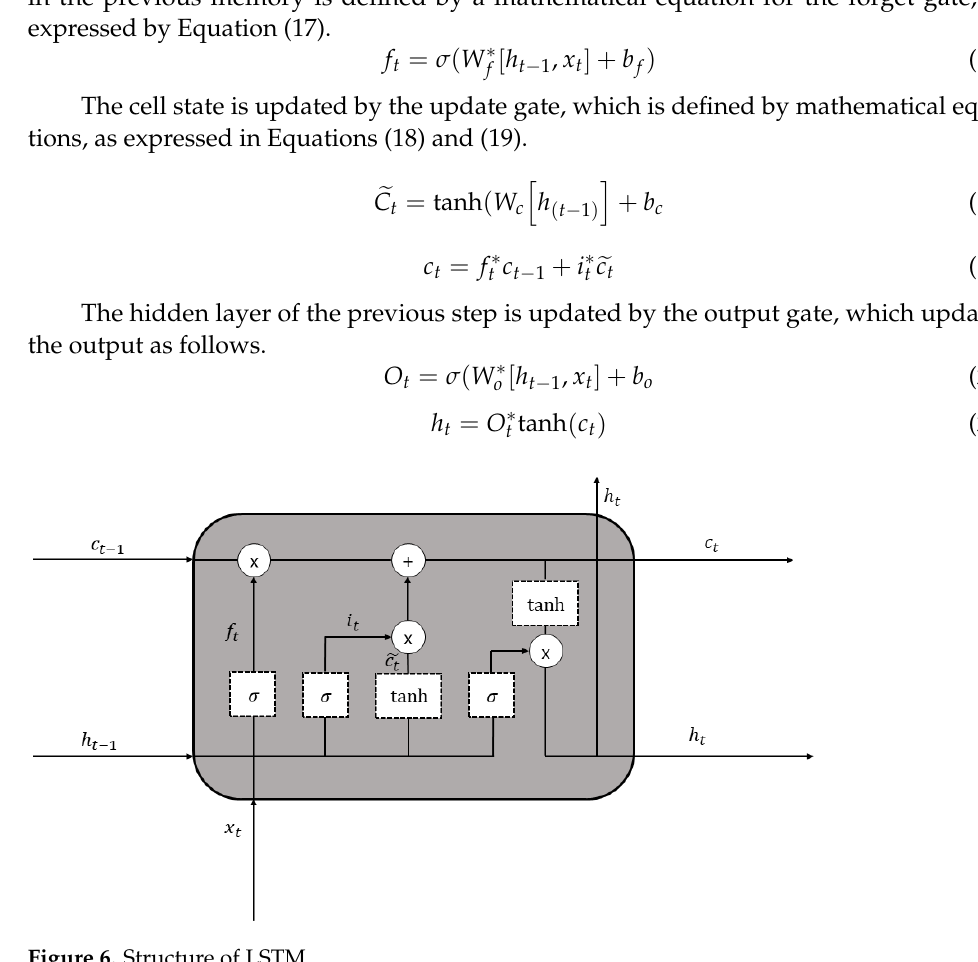
Figure 6. Structure of LSTM.